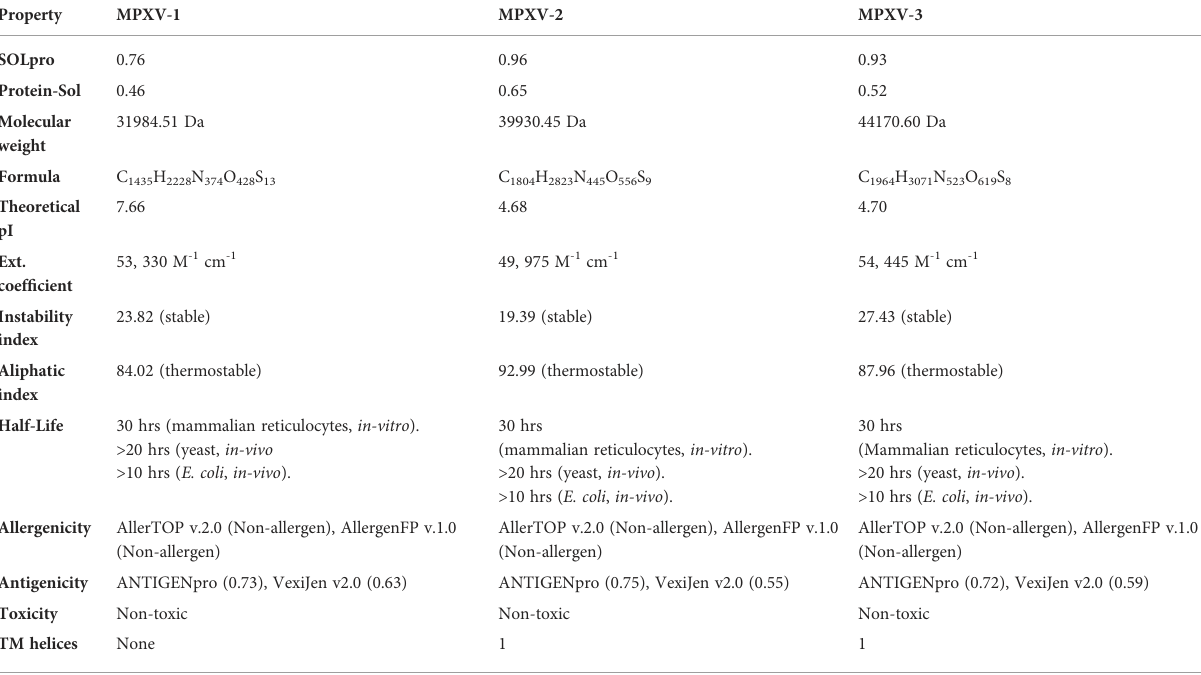
TABLE 4 Evaluation of Estimated solubility, immunological, and physicochemical properties of designed vaccine constructs by Expasy ProtParam server.